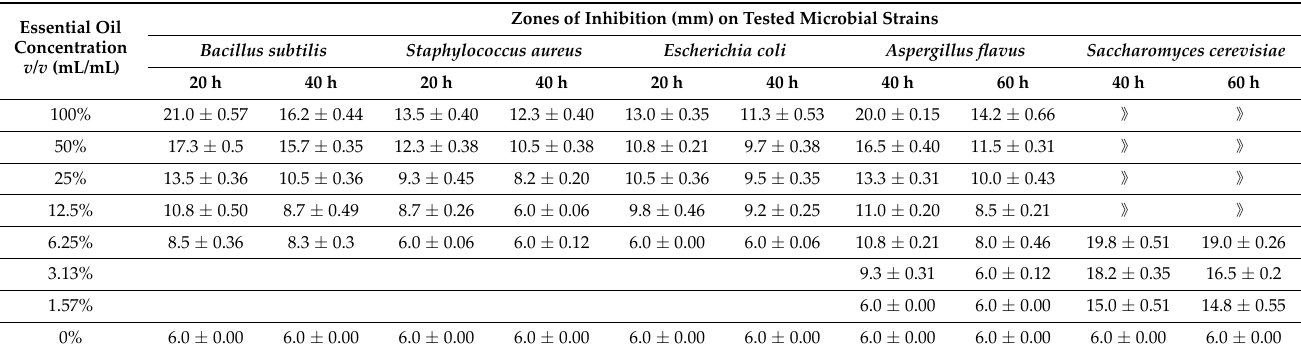
Table 2. Antimicrobial activity of essential oil by Agar well diffusion